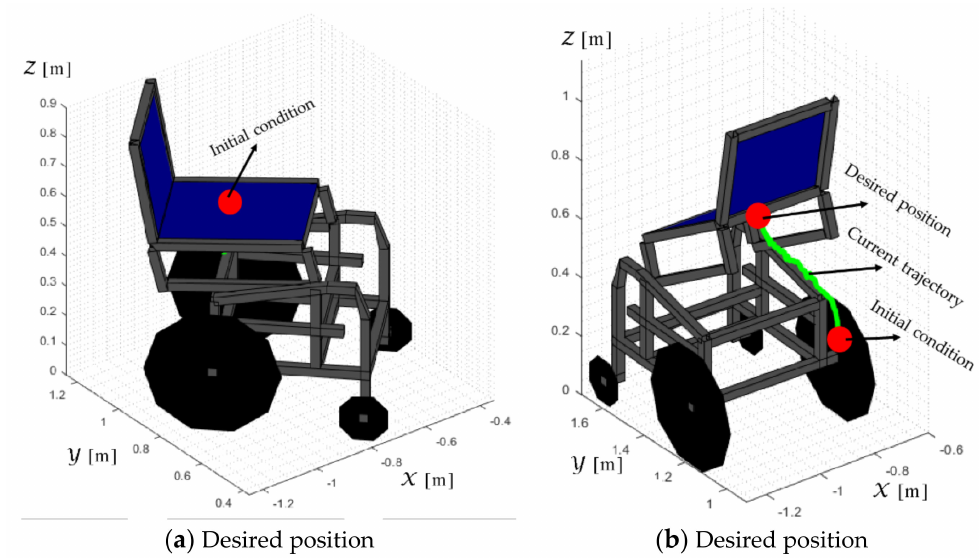
Figure 16. Stroboscopic movement of the human–robot system based on the real experimental data.